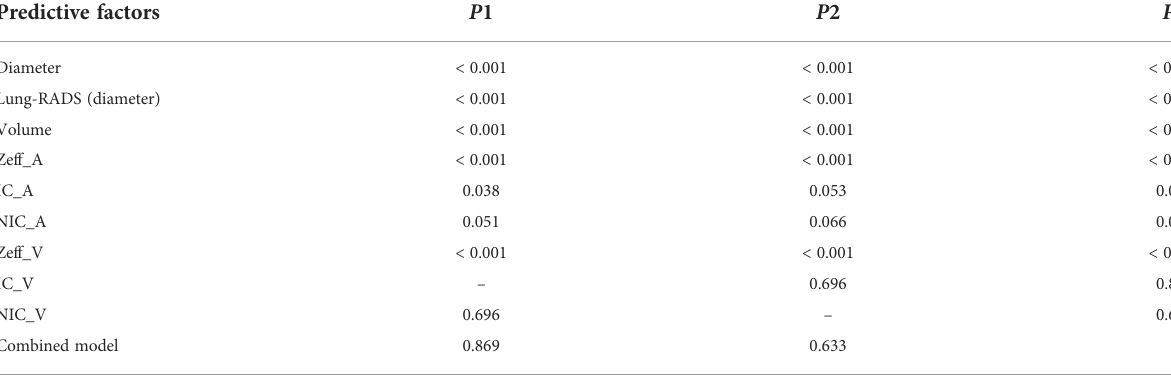
TABLE 3 Comparisons of area under curves among predictive factors.